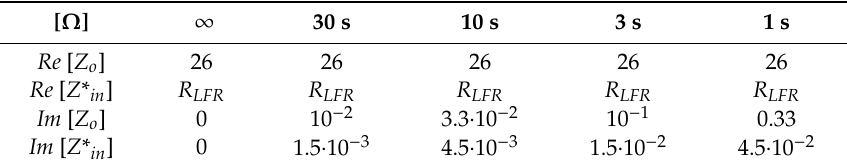
Table 3. Real and imaginary parts of Z o and Z * in for C f = 10 μ F, and different lapse times Δ T between waves.